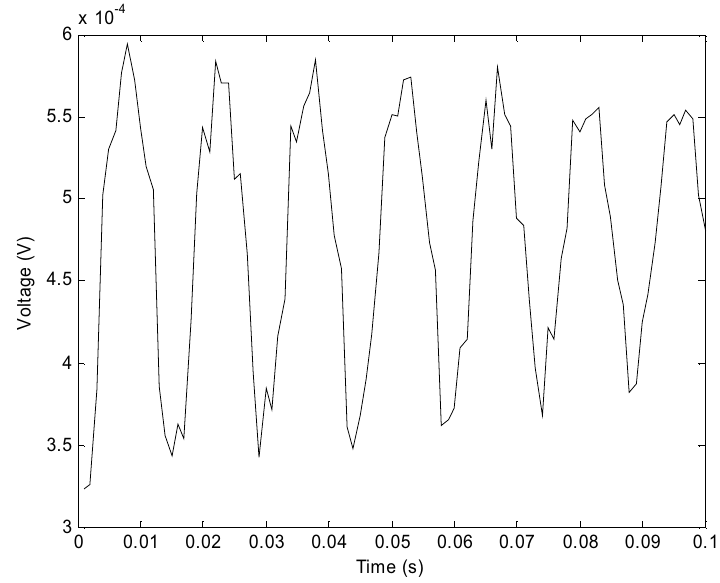
Fig. 9. PZT sensor voltage for the system rotating at 40 Hz. An upward step force is acting at the tip of the blade where PZT sensor is